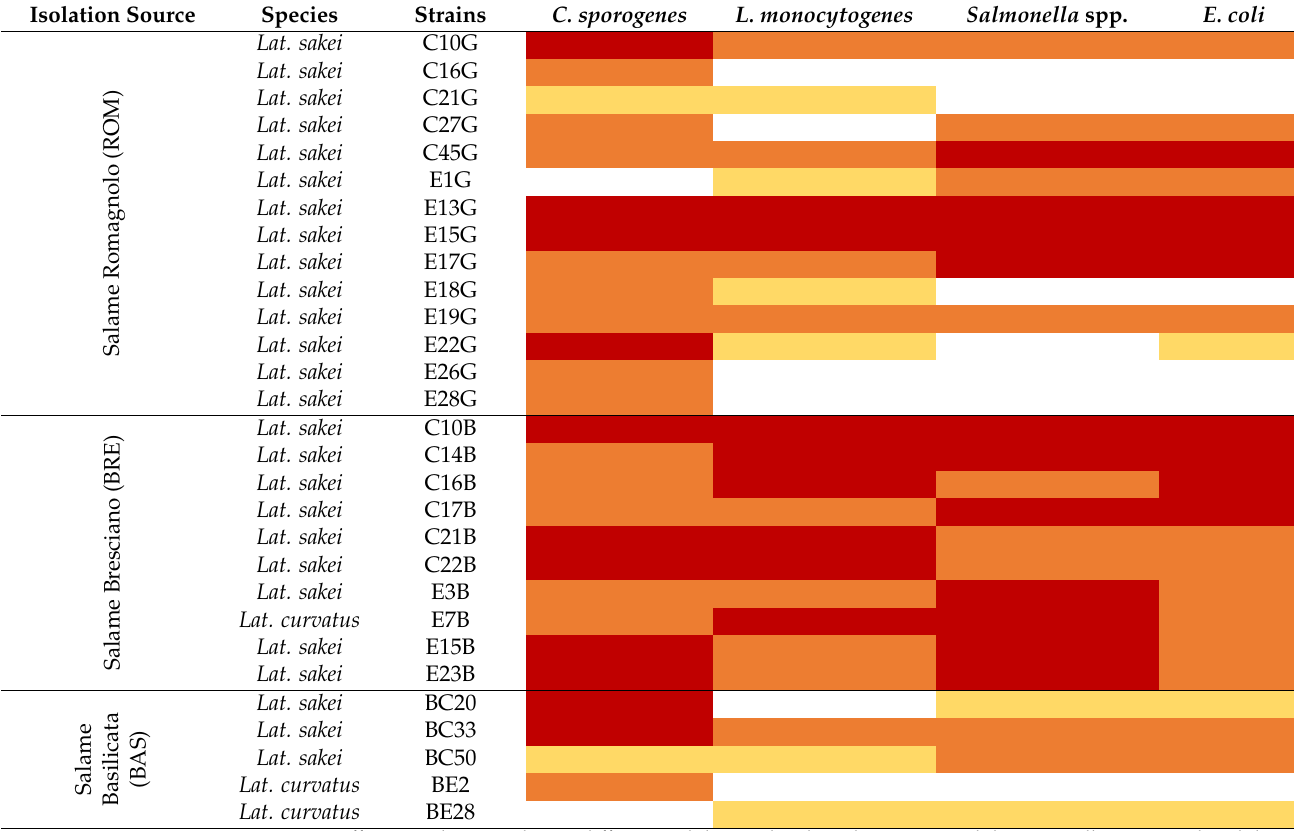
Table 6. Spot-test assay: direct antagonistic activity of meat-borne LAB against foodborne pathogens. Isolation